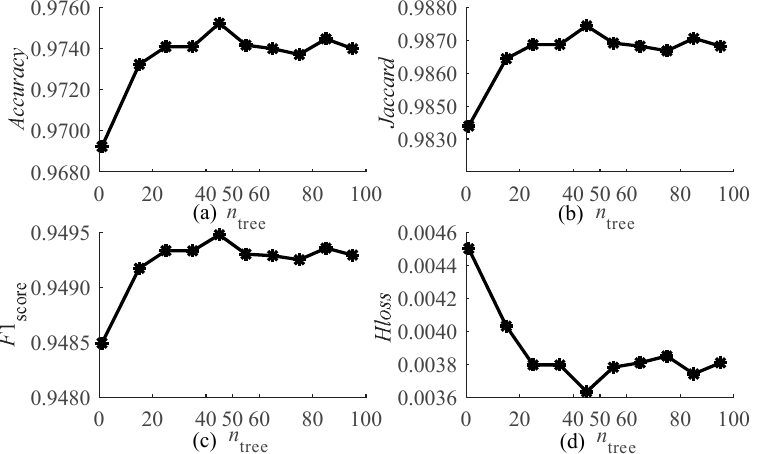
Figure 5. Evaluation results of ML-RF with different number of trees in the forest ( n tree ). ( a ) Accuracy Score; ( b ) Jaccard Similarity; ( c ) F1 Score; ( d ) Hamming Loss.